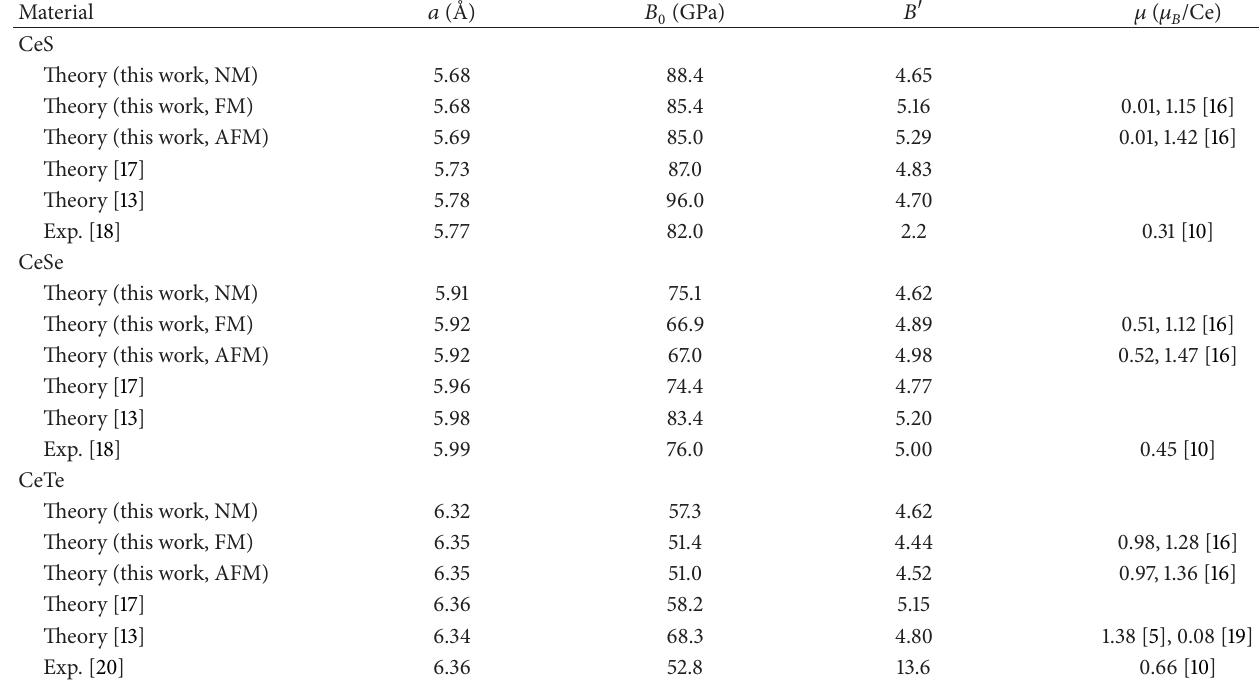
Table 1: Calculated lattice parameter 𝑎 0 (in ˚A), bulk modulus 𝐵 0 (in GPa), pressure derivative of the bulk modulus 𝐵 󸀠 , and magnetic moment (in 𝜇 𝐵 /Ce) for CeS, CeSe, and